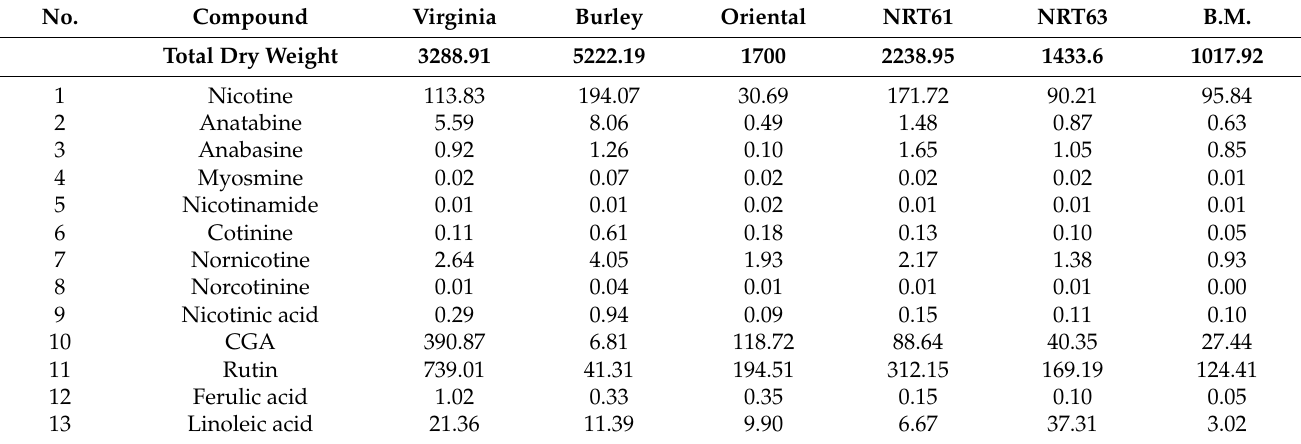
Table 6. Theoretical yield in kilograms per hectare (kg/ha) of valuable tobacco compounds based on recorded and typical mass yields of tobacco species and varieties from our internal